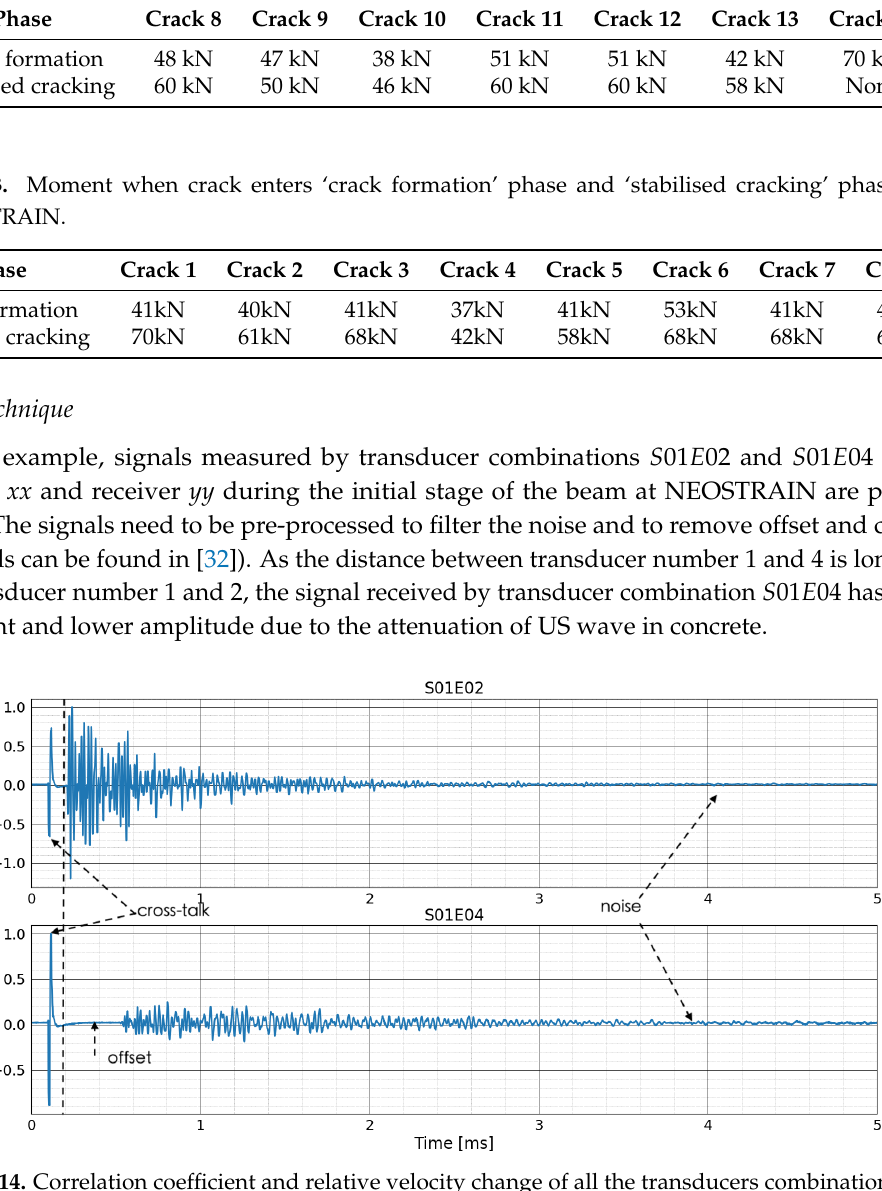
Figure 14. Correlation coefficient and relative velocity change of all the transducers combinations in test at